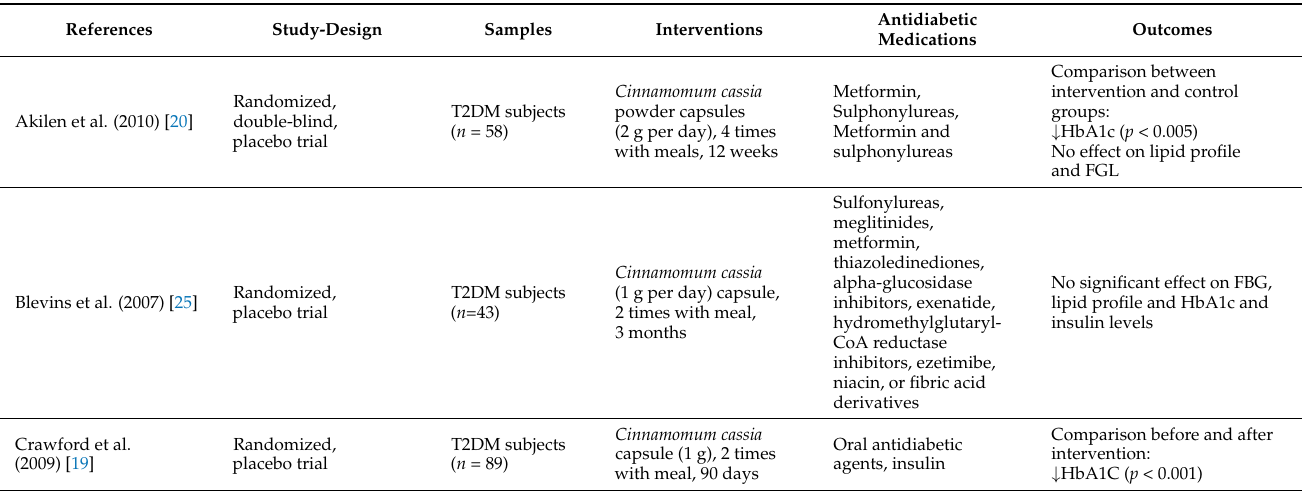
Table 1. A summary of the effects of cinnamon on glycemia and lipid profile of type 2 diabetic and impaired glycemia